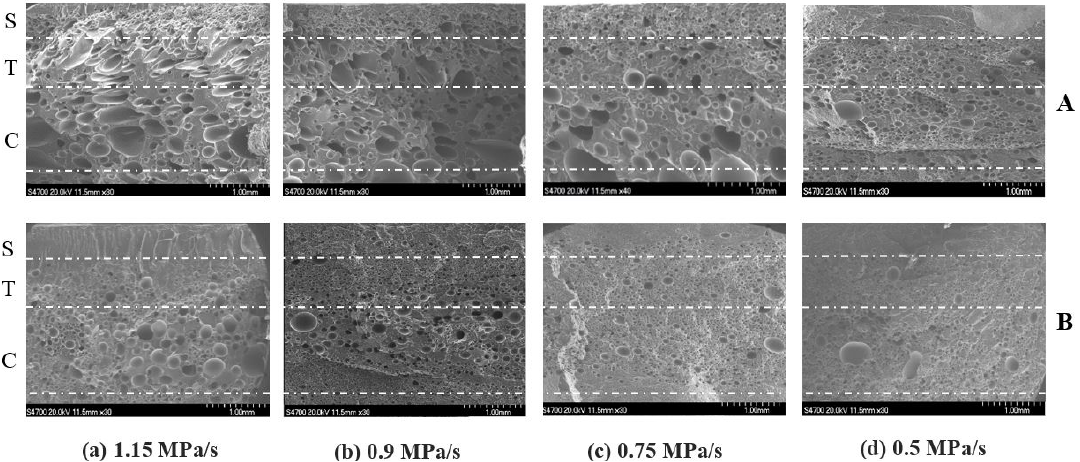
Figure 3. Representative SEM micrographs of the injected foams of pure PLA ( A ) and PLA–nanoclay ( B ) with four different mold opening rates. PLA,